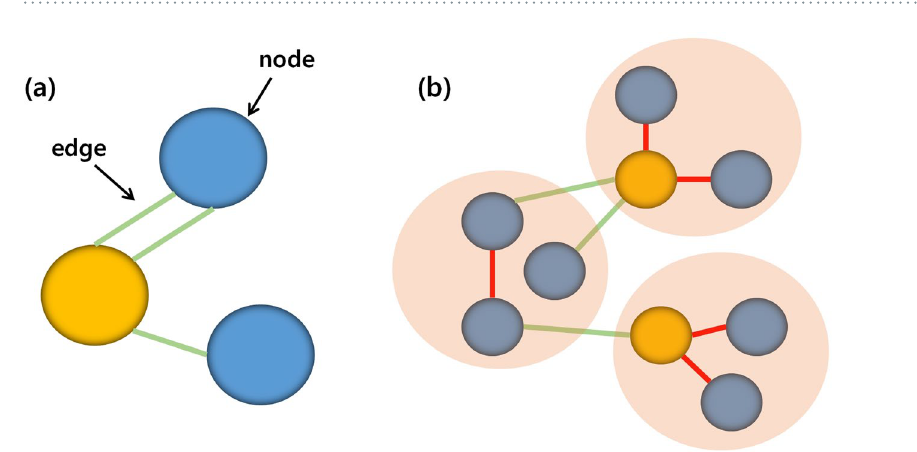
Figure 4. Changes in the network hub position at different scales. A simple graphical model showed a mathematical description of a network, consisting of nodes (blue circles), hubs (yellow circles), connections between the nodes (green lines), and u-fibers or short fibers of nodes (red lines). The schematic diagram represented the different hub regions at different nodal